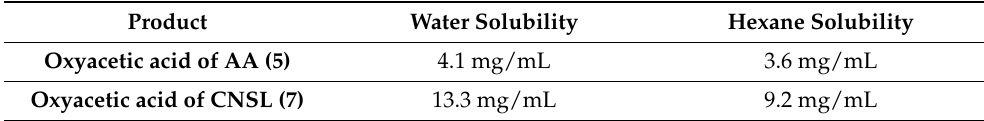
Scheme 6. Oxyacetic acid of CNSL ( 7 ) synthesis and salt formation. Table 8. Water and hexane solubilities of oxyacetic acid of anacardic acid ( 5 ) and oxyacetic acid of CNSL ( 7